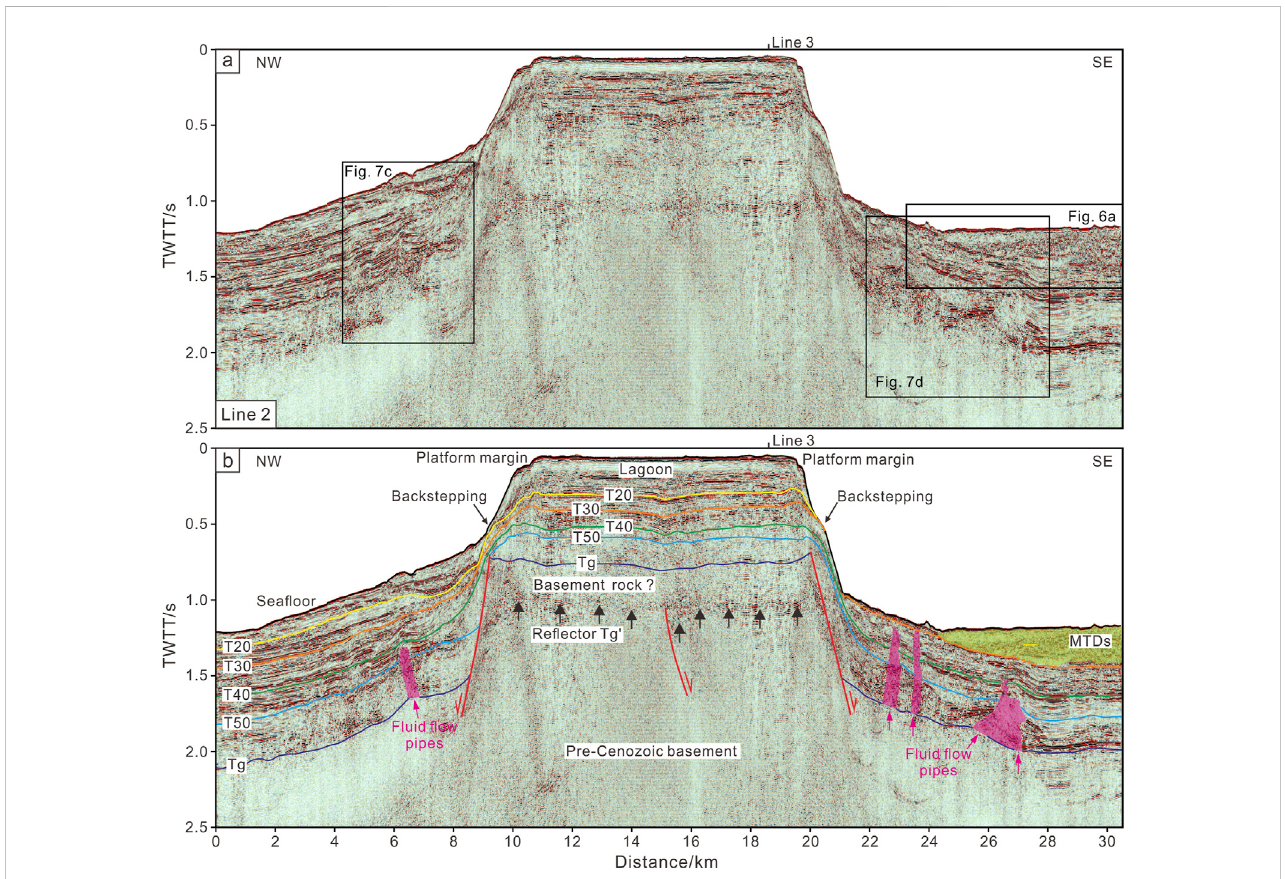
FIGURE 4 Line 2 multi-channel seismic re fl ection pro fi le (A) and its interpretation (B) . See Figure 1 for location. Red lines represent normal faults. Carmine areas mark the fl uid fl ows pipes and arrows show their migrated directions. Translucent grass green area marks the MTDs. Black arrows mark the location of re fl ector Tg ’ . T20, T30, T40, T50, Tg, Tg ’ : seismic re fl ectors. TWTT: two-way travel